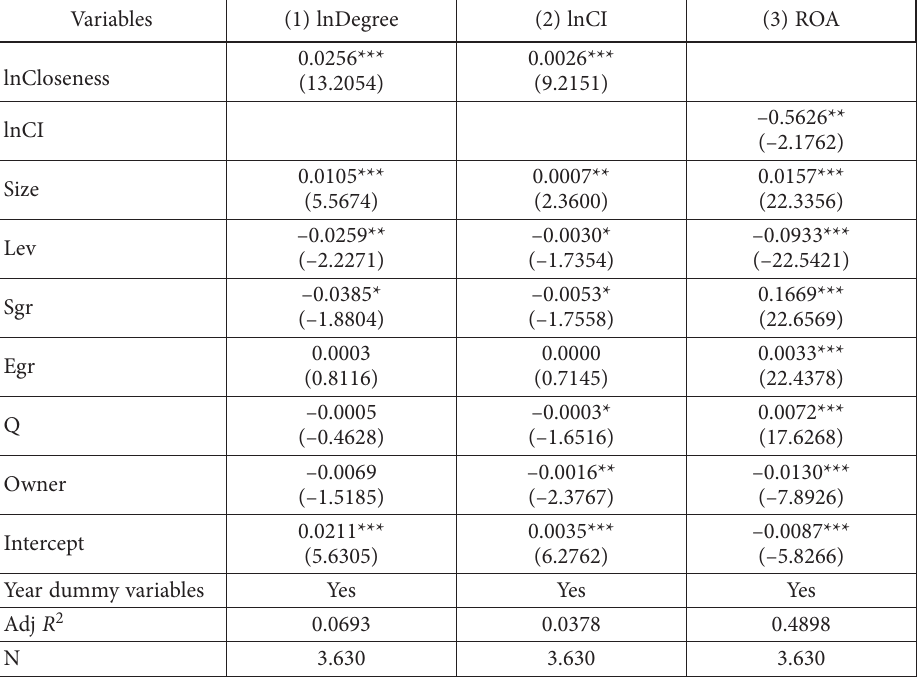
Table 3. Results of endogeneity